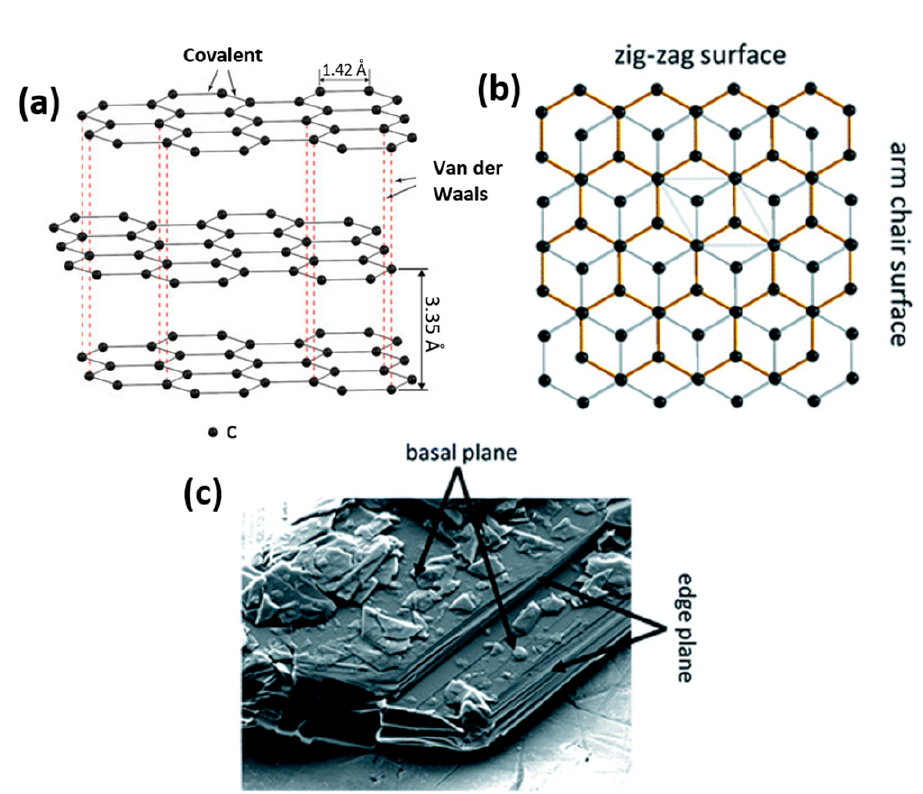
Figure 3. Schematic illustration of the layered graphite structure and the resulting presence of basal and edge planes ( a ) showing the difference between zig-zag and arm chair surfaces ( b ) and SEM micrograph of the basal and edge planes for a graphite particle ( c ).